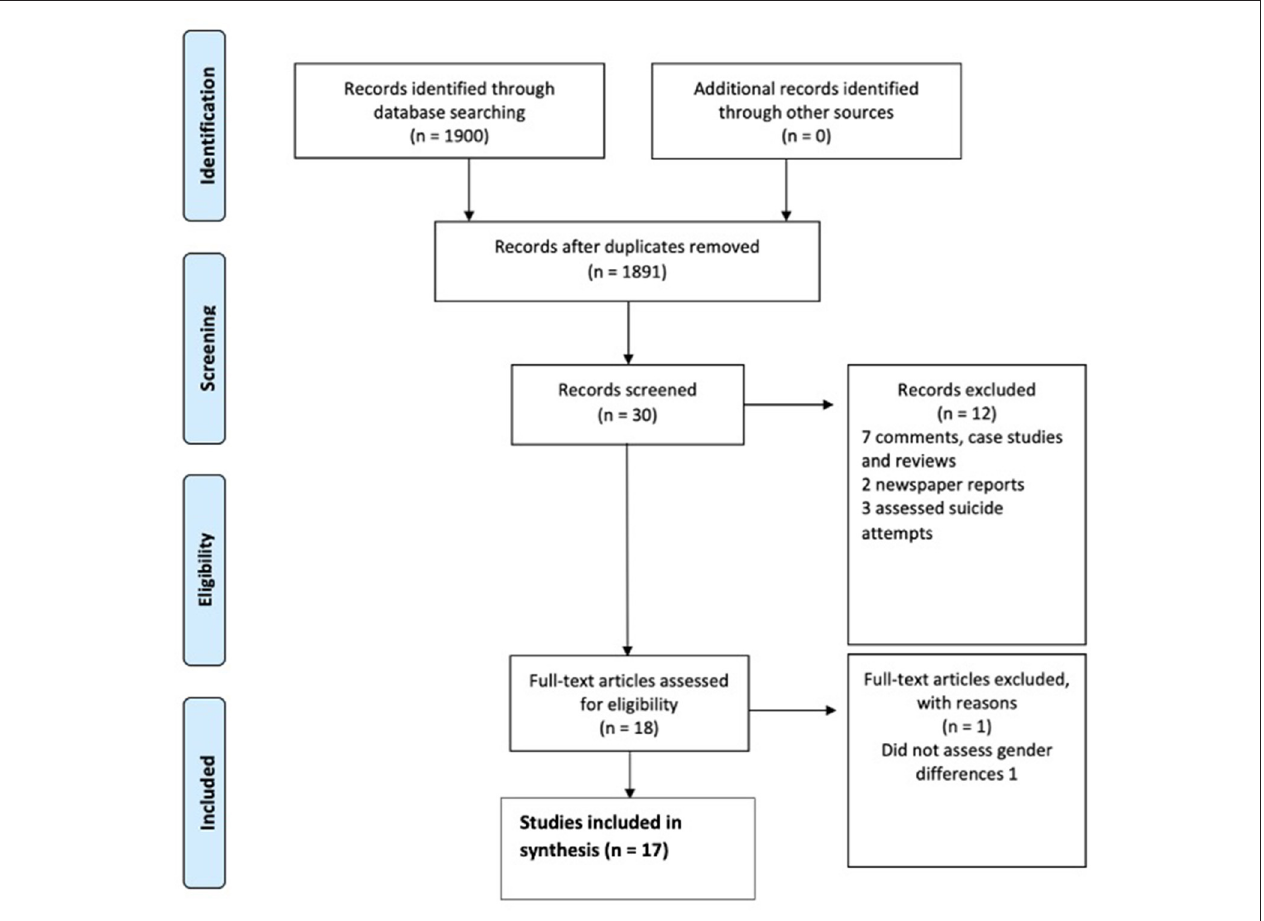
FIGURE 1 | PRISMA flow diagram of study